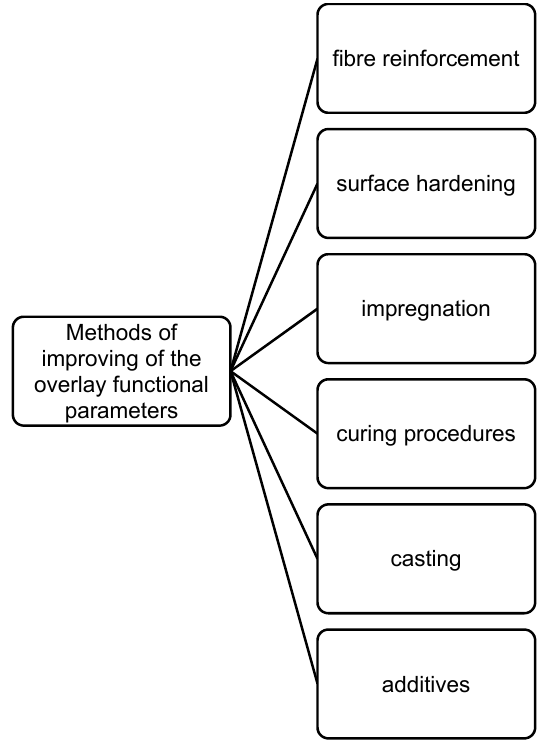
Figure 20. Methods of improving the overlay functional parameters.